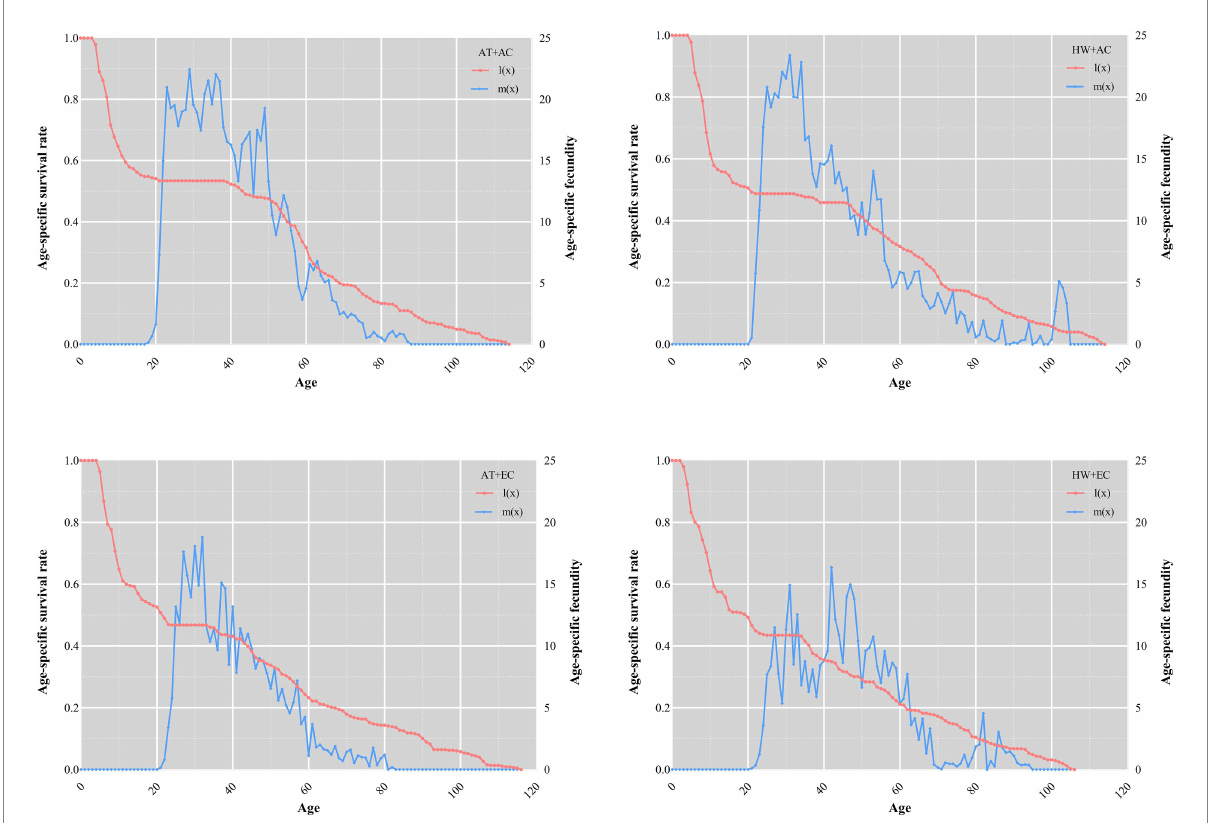
FIGURE 3 Effect on age-specific survivorship and fecundity of Ophraella communa after feeding on common ragweed grown under different treatment conditions. AT denotes the ambient temperature condition; HW denotes the heat wave condition. EC and AC represent elevated atmosphere CO 2 concentration and ambient atmosphere CO 2 concentration,